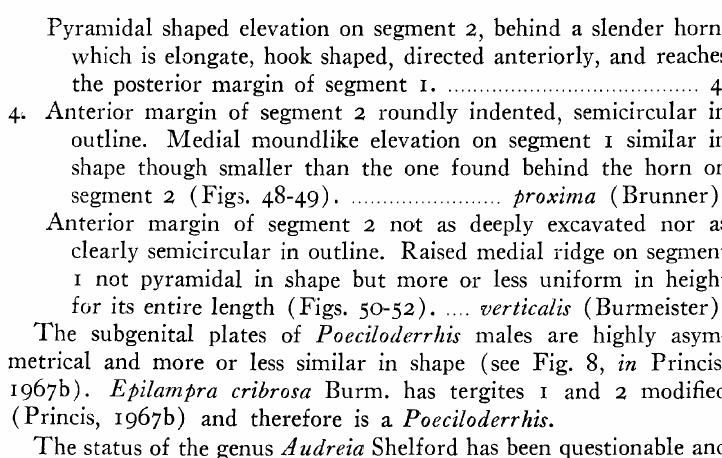
Figs. 50-52. Poeciloderrhis eerticalis. (58, USNM). Serra Carat.a, Matto Grosso, Brazil; genitalia in Figs. 13-15. The tergal glands are indicated by arrows (Fig. 50), and circled numbers (Fig. 51, dors.al). Fig. 52 is a lateral view. (dot. Gurney). R1 medial ridge on segment 1; H sclerotized horn on segment 2; M2 pyramidal shaped horn on segment